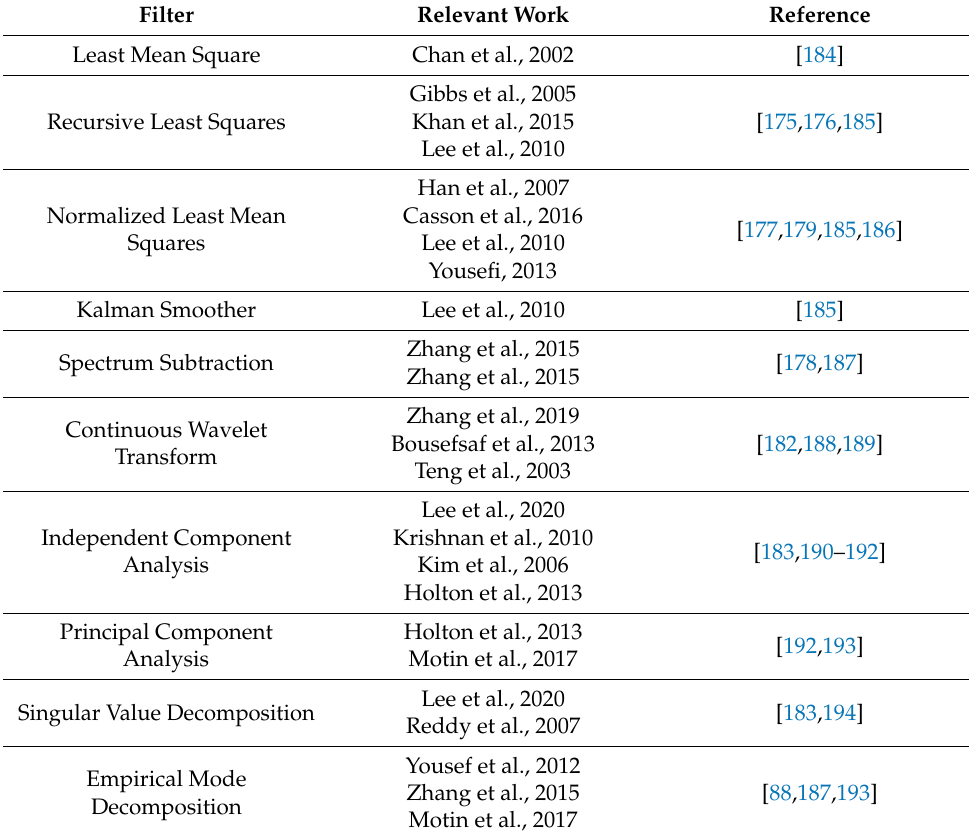
Table 6. Adaptive filters utilized to eliminate or reduce motion artifacts independently and in conjunction with secondary sensors. This is not an all-inclusive